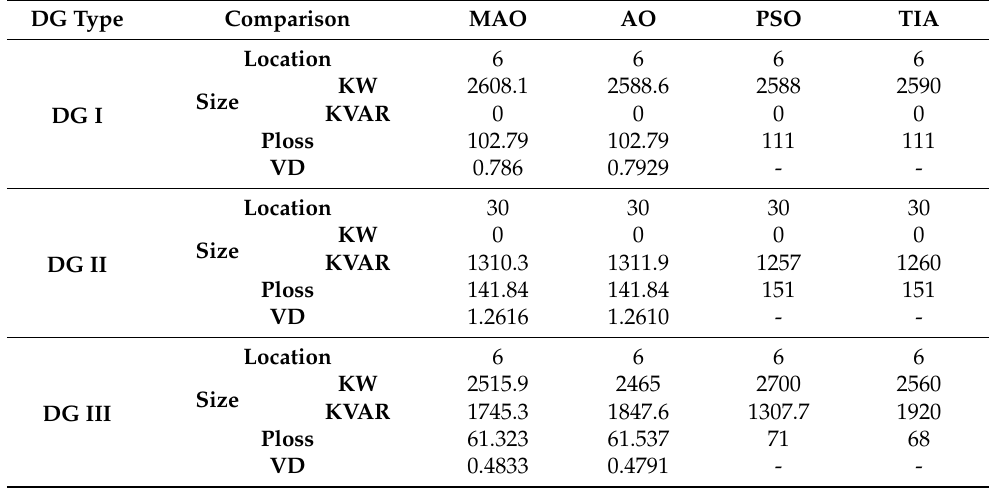
Table 16. The compared results of different algorithms in the IEEE 33-bus test